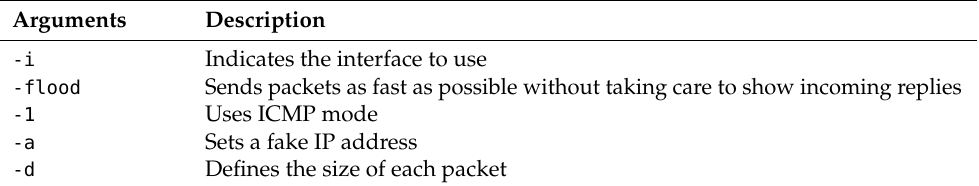
Table 1. Hping3 Tool Arguments Used in Our Testing